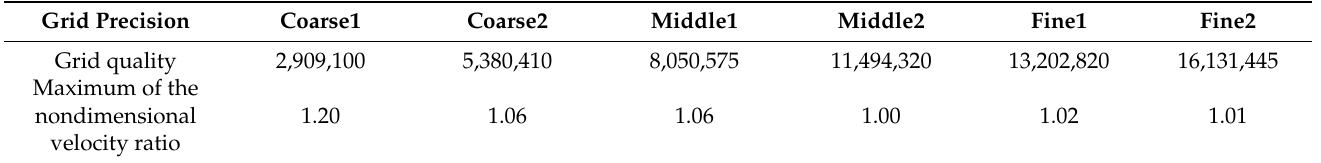
Table 1. Calculation